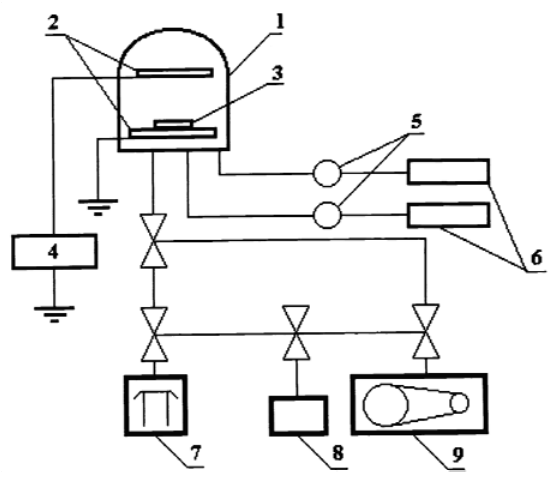
Figure 5. Schematic of the RF plasma reactor for HMDSO polymer deposition: